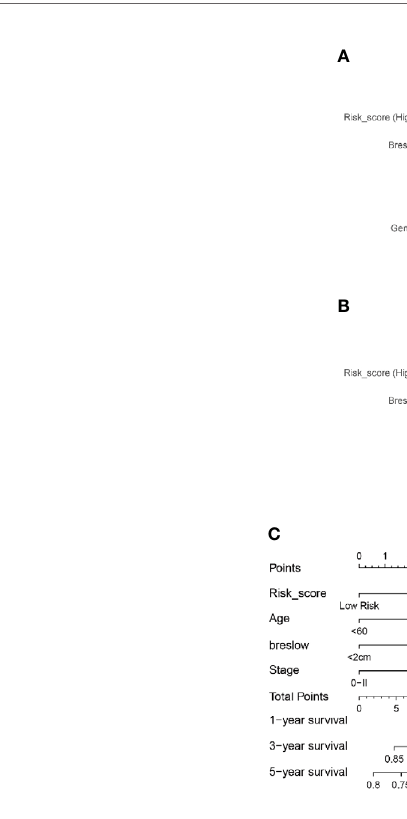
FIGURE 6 | Integration analysis of risk score and clinical characteristics to predict the survival of melanoma patients. (A) Univariate analysis shows only gender is not signi fi cantly correlated with disease progression. (B) Multivariate analysis shows risk score, breslow, and age is signi fi cantly correlated with disease progression. (C) Nomogram including risk score constructed to predict the 1-, 3-, and 5-year survival of melanoma patients in the TCGA cohort. (D, E) Calibration curve of the nomogram for predicting the probability of OS at 1 and 3